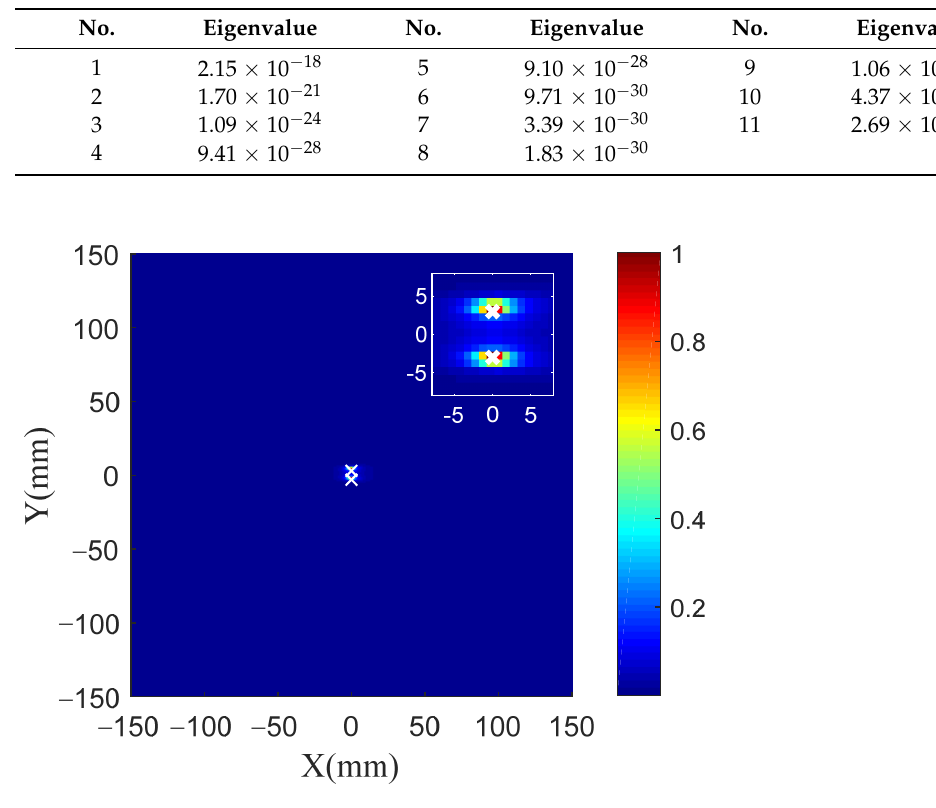
Figure 13. TR ‐ MUSIC imaging of damage with distance less than half ‐ wavelength.